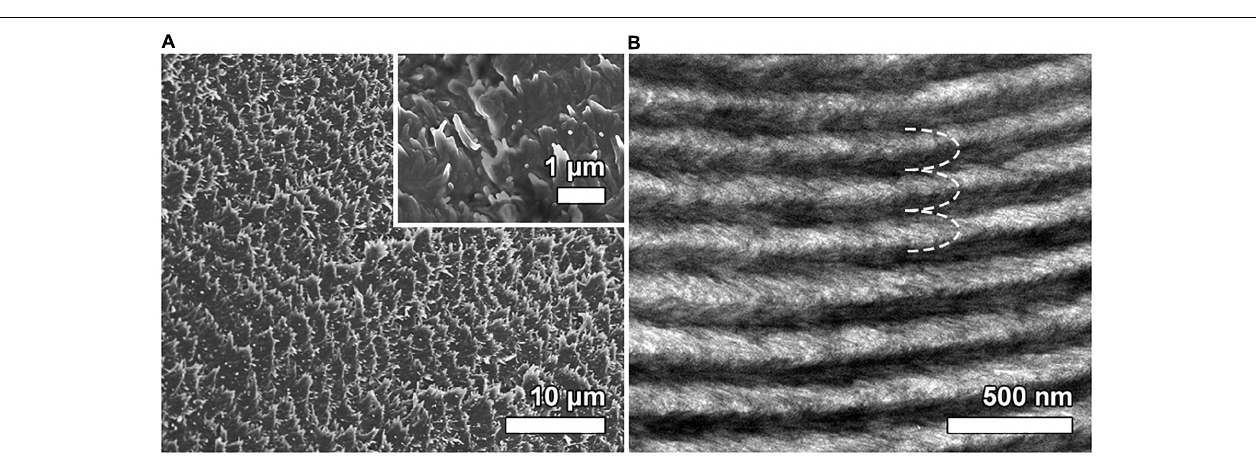
FIGURE 2 | SEM image of the surface view of the CS4-Rh sample (A) . The inset panel in A displays an SEM image with higher magnification highlighting the left-handed rotation of the chiral nematic organization. TEM image of an oblique cross-section of the CS4-Rh composite (B) . The dashed white line shows the arc-like appearance generated through the chiral nematic